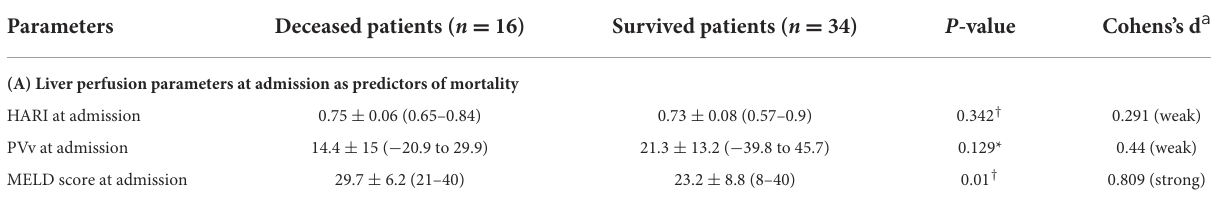
TABLE 3A Liver perfusion parameters as predictors of mortality.